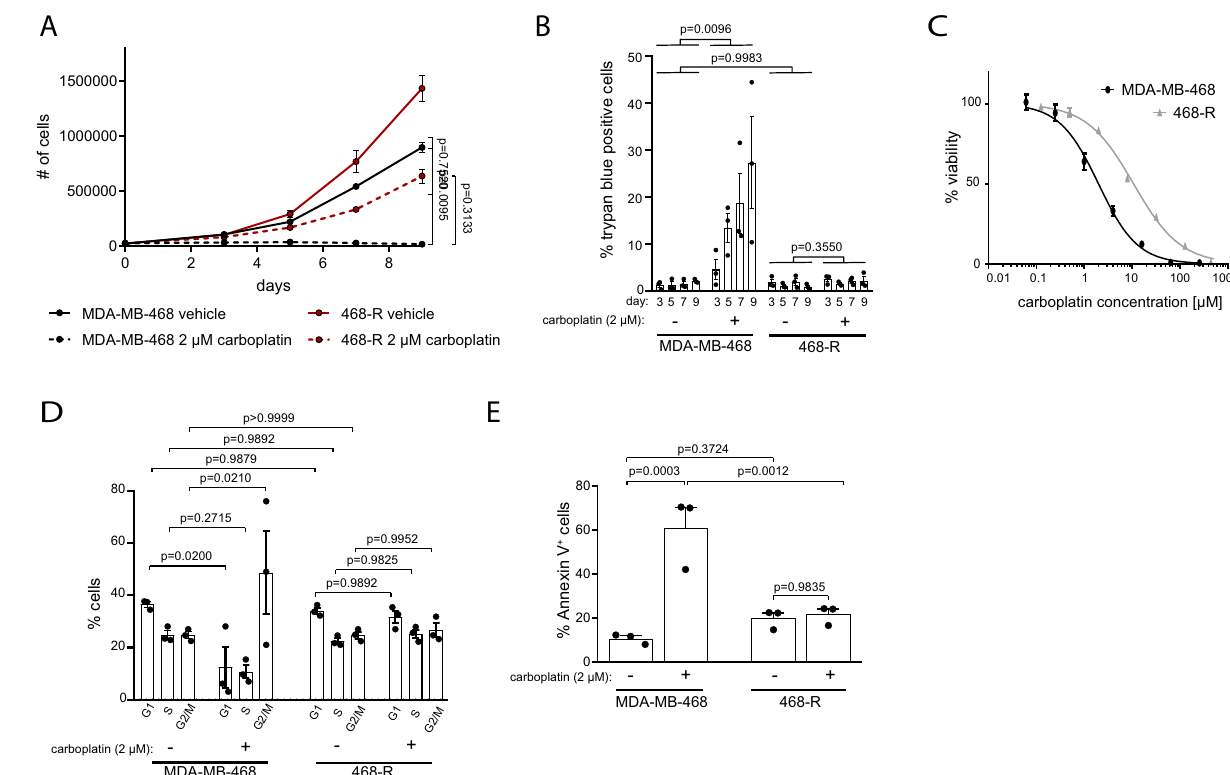
Figure 1. 468-R cells can grow in the presence of carboplatin. ( A , B ) Cell growth ( A ) and cell death ( B ) of MDA-MB-468 and 468-R cells treated with vehicle or 2 µM carboplatin. Data are shown as Mean ± SEM. P values were calculated by two-way ANOVA with Geisser–Greenhouse and Tukey’s correction. (N = 3). ( C ) Dose–response after three days carboplatin treatment of MDA-MB-468 (N = 3) and 468-R (N = 6) cell lines. R 2 : MDA-MB-468 = 0.9799, 468-R = 0.9872. Data are shown as Mean ± SEM. ( D , E ) Cell cycle distributions and apoptosis analysis of MDA-MB-468 and 468-R cells treated for 5 days with vehicle or 2 µM carboplatin. Propidium iodide- ( D ) or Annexin V-stained ( E ) cells were analyzed by flow cytometry. Data are shown as Mean ± SEM. P values were calculated by two-way ANOVA with Geisser–Greenhouse and Tukey’s corrections. (N =